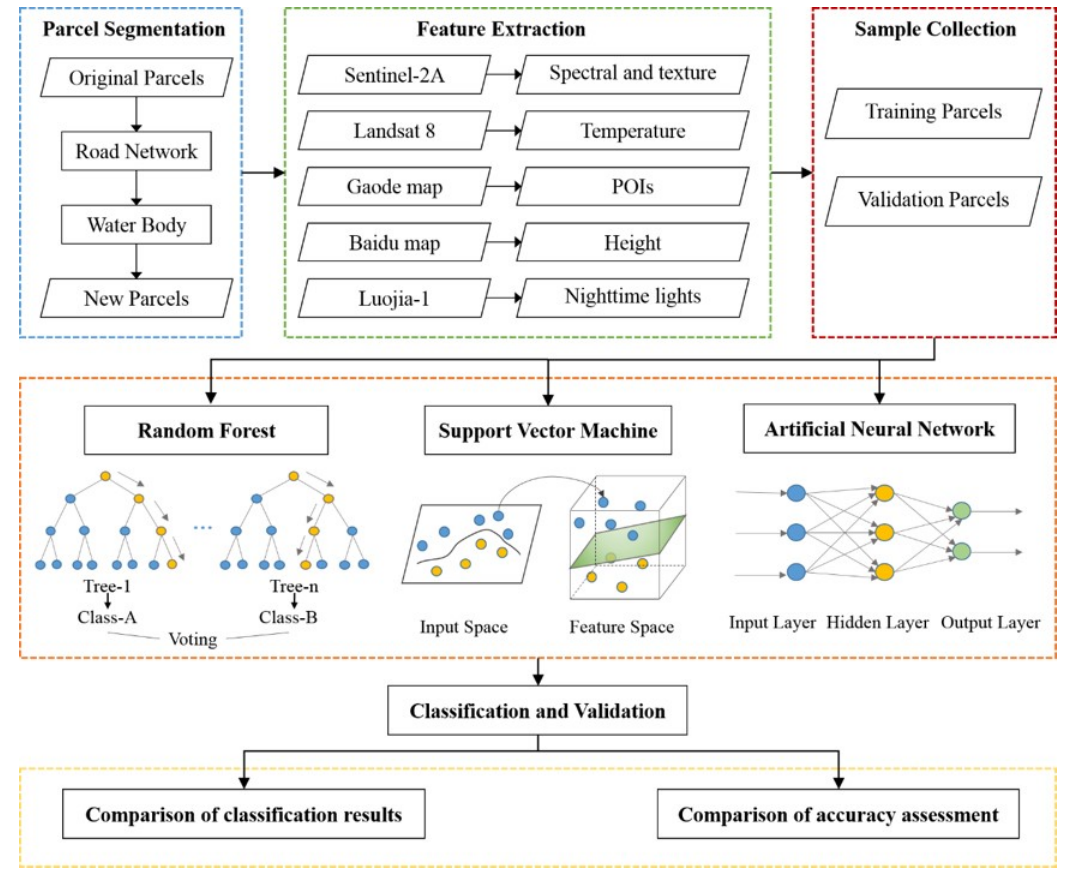
Figure 1. Technique flow chart of land-use classification.